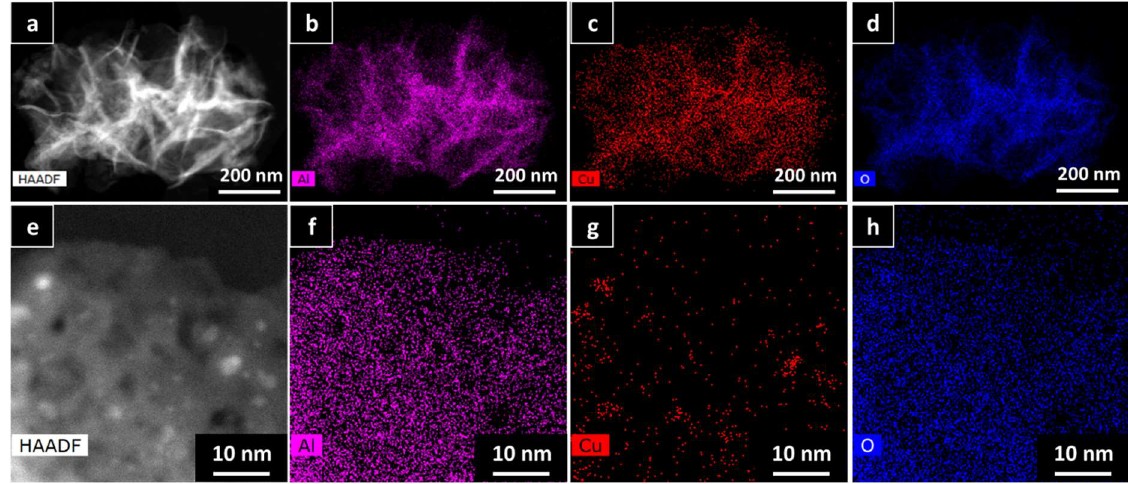
Figure 3. HAADF-HRSTEM EDX patterns of AlNFs decorated with 10 wt% of Cu (AlNFs-Cu-10 catalyst) reduced prior to the analysis: ( a – d ) small magnification and ( e – h ) large magnification.